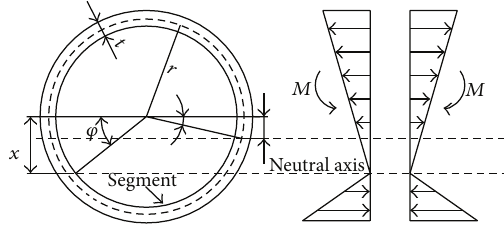
Figure 11: The longitudinal bending calculation